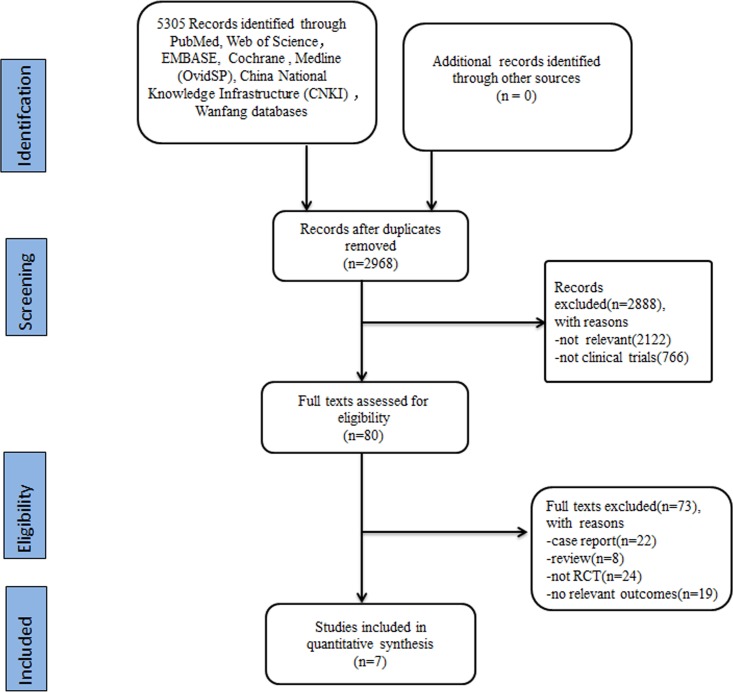
Flow diagram of studies retrieval and screening.